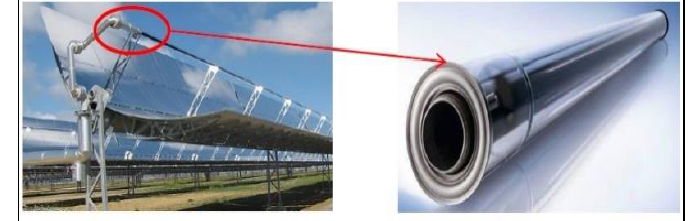
Figure 1: Parabolic solar concentrator trough collector and absorber tube.